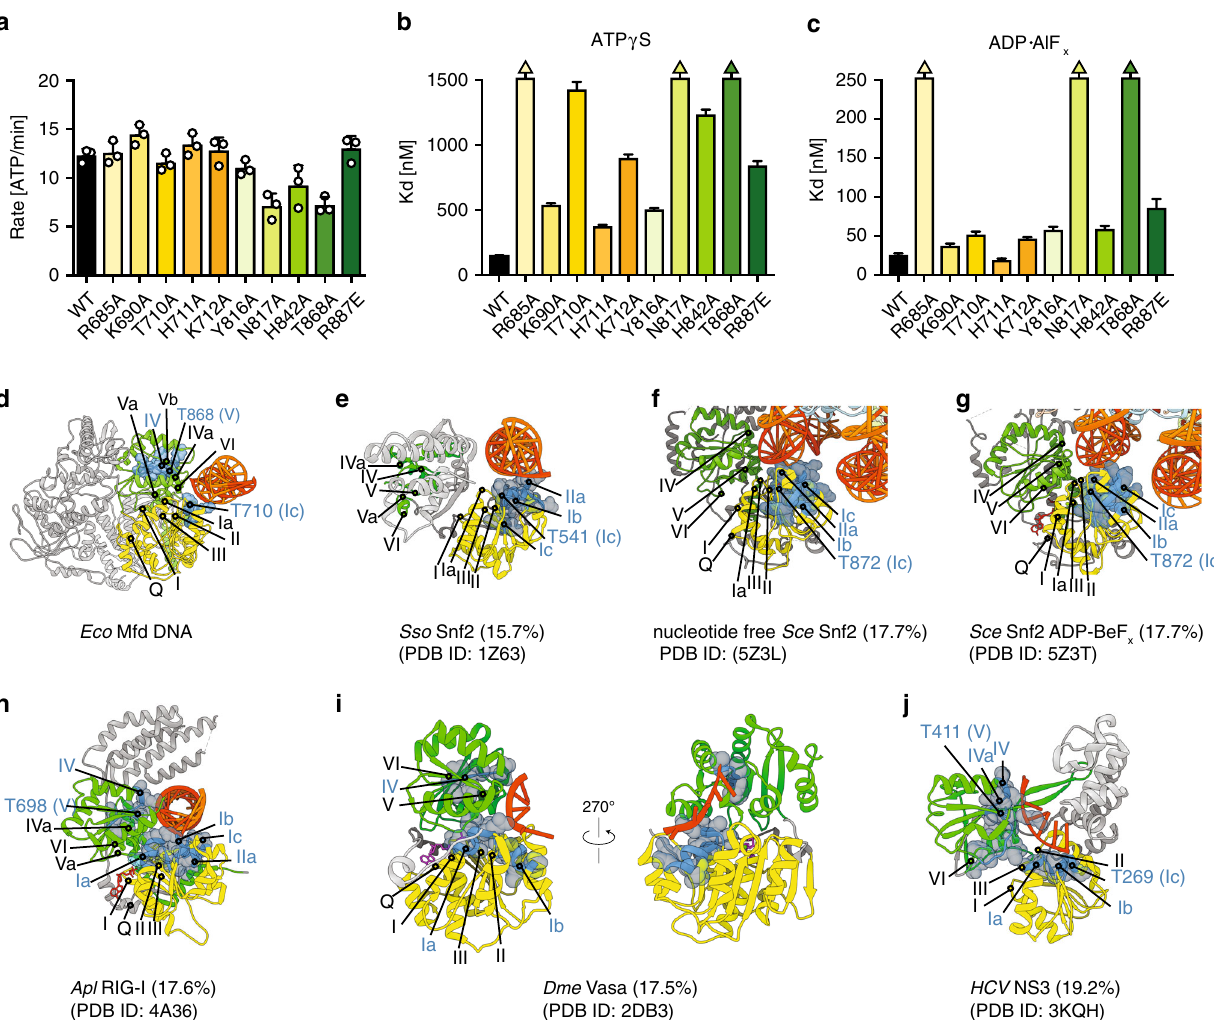
Fig. 6 Key roles for R685, N817, and R868 in DNA loading. a Steady-state ATPase activities of single Mfd variants. ATP hydrolysis rates were measured using an ATP/NADH-coupled ATPase assay. Data shown are the means ± SD ( n = 3). Variants are color-coded by domain as in Fig. 2a (D5 variants, yellow hues; D6 variants, green hues). Data for Mfd R685A and Mfd N817A are replotted for convenience from Le et al. 16 . b – c Equilibrium dissociation constants for the Mfd-dsDNA interaction derived from fl uorescence anisotropy binding curves. D5 and D6 variants are color-coded by domain as in Fig. 2a. Data represent mean values ± SD ( n = 3). Error bars are often smaller than symbols. Arrows indicate data sets that could not be reliably fi t to a binding model owing to compromised af fi nity for DNA, and likely represent an overestimation of the true af fi nity. Binding curves are shown in Supplementary Fig. 7. d – j Structural comparison between double-stranded nucleic-acid translocases and Escherichia coli ( Eco ) Mfd (d) using superpositions restricted to the C α trace of D5. Shown are Sulfolobus solfataricus ( Sso ) Snf2 (r.m.s.d. of 1.1 Å, e ), Saccharomyces cerevisiae ( Sce ) Snf2 in its nucleotide-free (r.m.s.d of 1.4 Å, f ) and ADP • BeF x -bound state (r.m.s.d. of 1.4, g ), RIG-1 (r.m.s.d. of 1.0 Å, h ) and ssRNA translocases, Drosophila melanogaster ( Dme ) Vasa (r.m.s.d. of 0.9 Å, i ) and HCV NS3 (r.m.s.d. of 1.1 Å, j ). Bound Mg 2 + is shown as a dark green sphere, analog ADP • AlF 3 − as an aquamarine CPK model, bound nucleotide as magenta sticks, ADP as a red CPK model, BeF x as a dark red CPK model and nucleic-acid strands are colored red and orange. The two lobes of the ATPase core are in yellow (N-terminal lobe) and green (C-terminal lobe), except for DNA-binding residues, which are highlighted as slate CPK models. Other domains are shown as a gray ribbon with annotated ATPase motifs. Those motifs contacting DNA are color-coded in slate font and some are not visible in these views. Indicated in parenthesis is the degree of conservation between the various motor cores and D5 and D6 of E. coli Mfd. Source data are provided as a Source Data fi